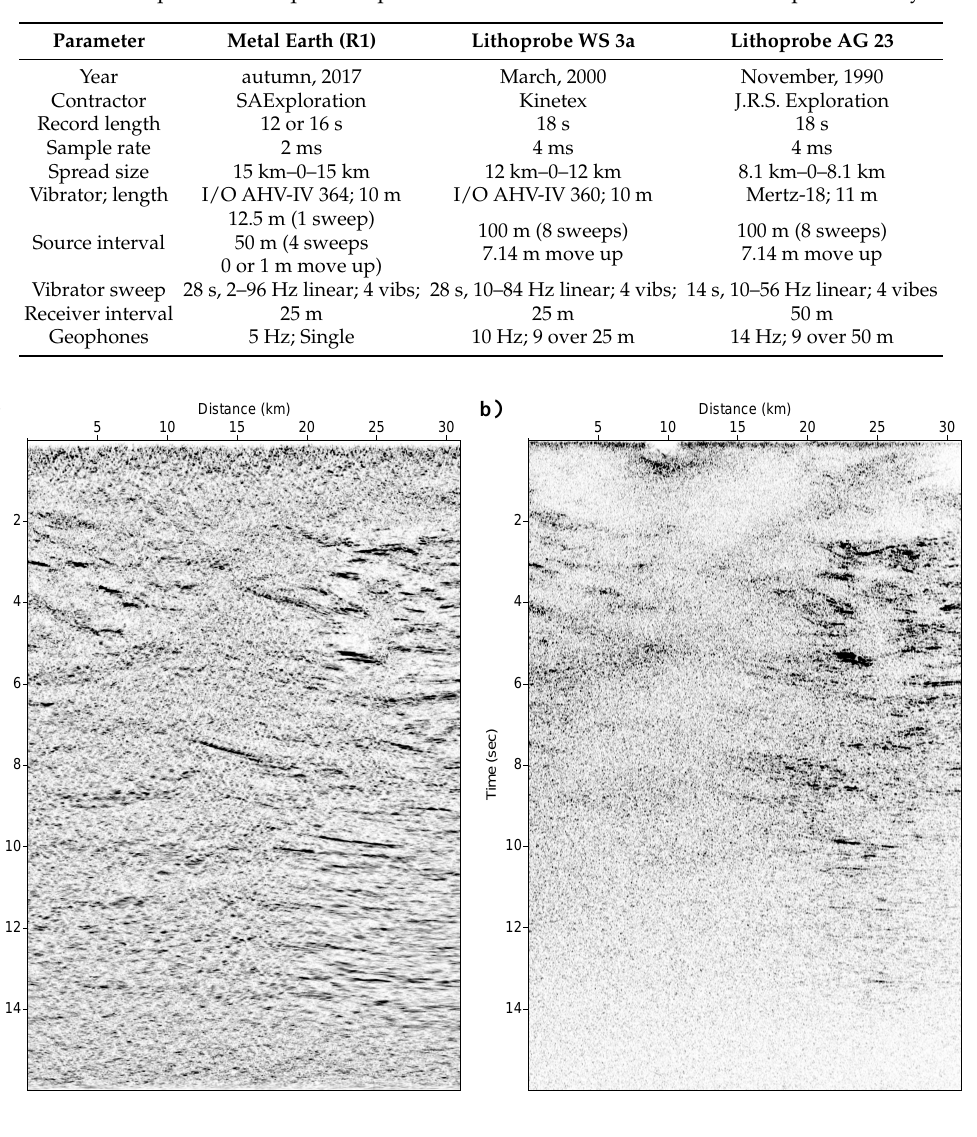
Figure 8. Comparison betweem the overlapped portions of Metal Earth’s Geraldton R1